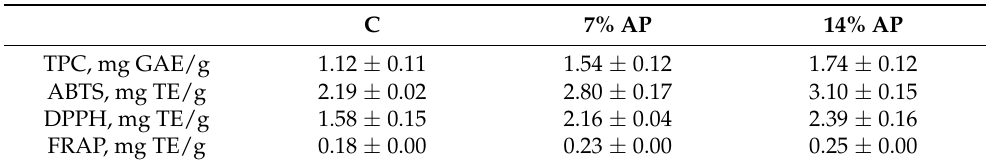
Table 4. TPC and antioxidant activity (ABTS, DPPH, and FRAP) of fortified salami at the end of ripening (mean values ± SD, n = 3).